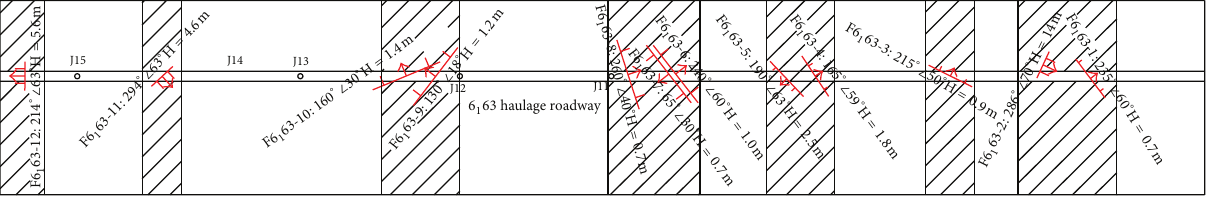
Figure 14: Diagram of zonal support for the h6 1 63 haulage